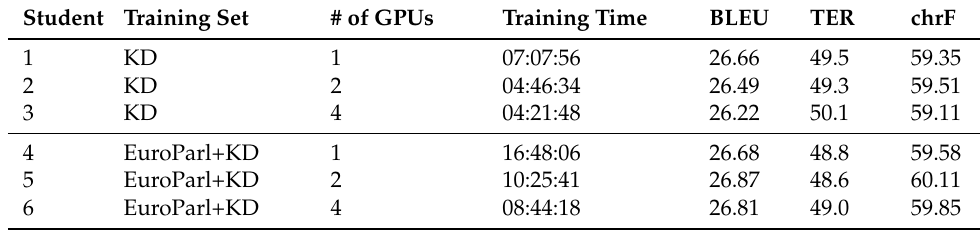
Table 5. Comparison of the performance of the student